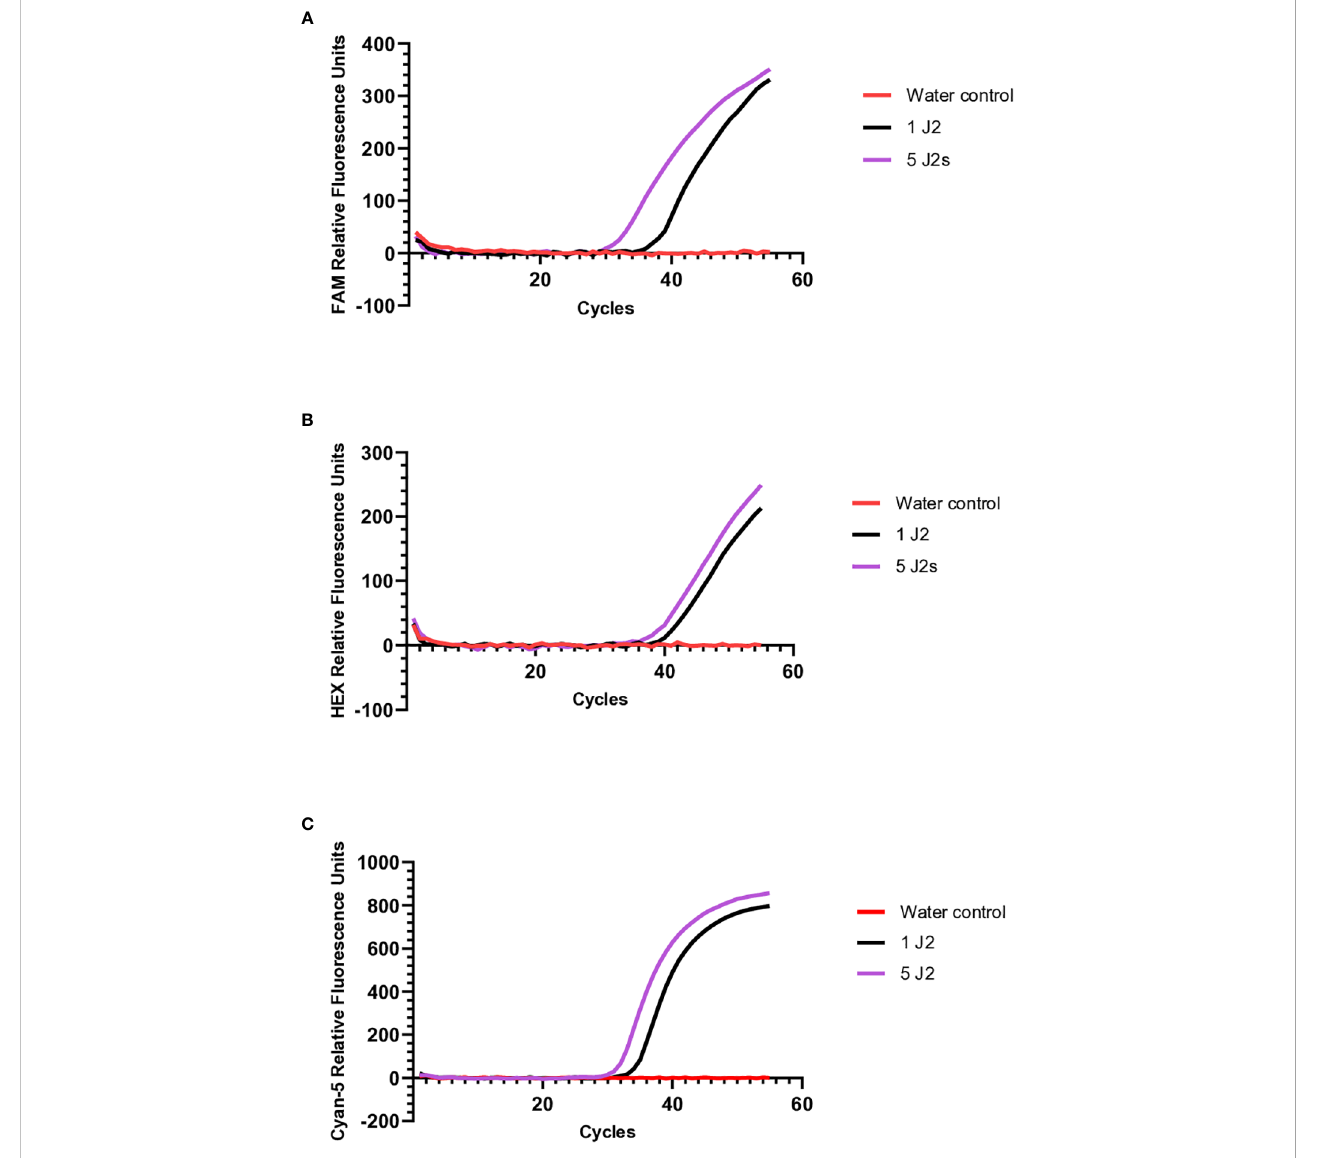
FIGURE 4 Molecular beacon RT-PCR ampli fi cation curves using crude extracts from 1 or 5 J2s of (A) M. chitwoodi (B) M. fallax , or (C) M. minor as the reaction